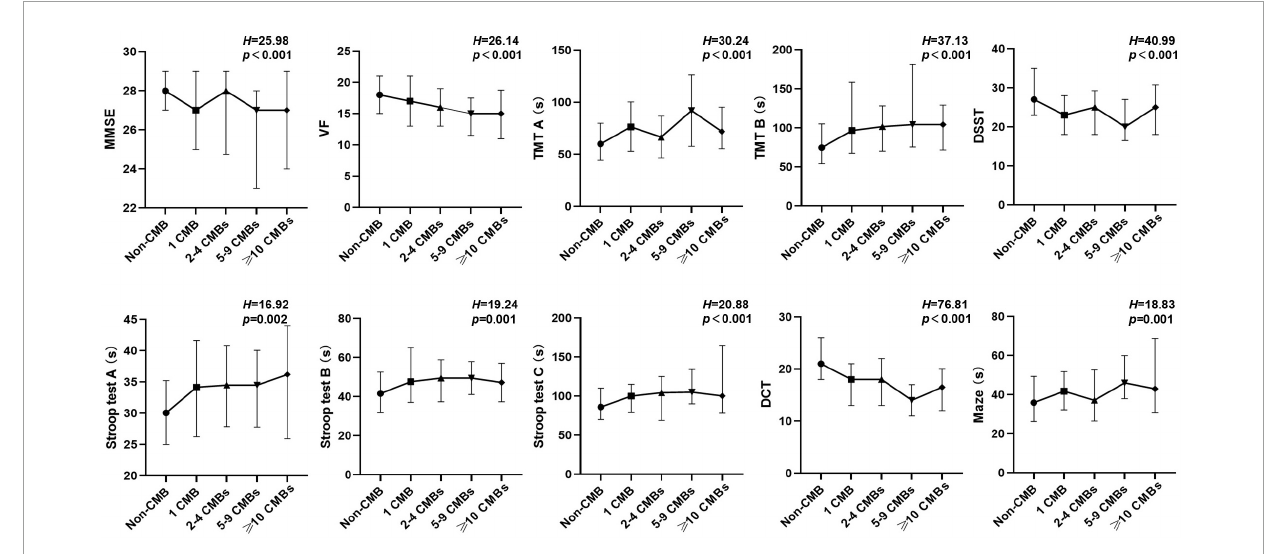
FIGURE1 Comparison of cognitive function among subjects with different CMB burden grades (Kruskal–Wallis H test). CMB, cerebral microbleed; DCT, digit cancellation test; DSST, digit-symbol substitution test; MMSE, mini-mental state examination; TMT, trail making test; VF, verbal fluency.